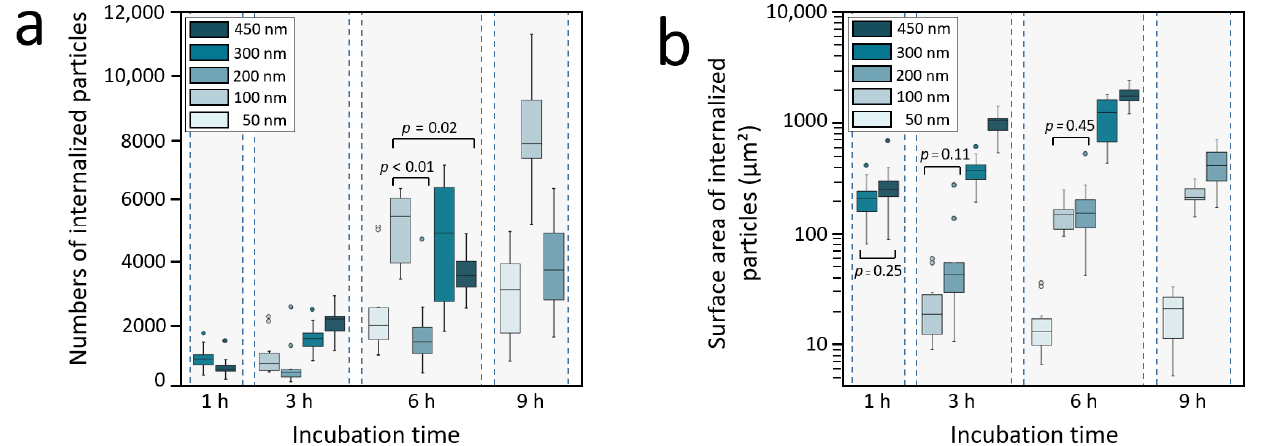
Figure 8. Internalization efficiencies. ( a ) Number of internalized NPs by one cell as a function of time ( p -values are only given for the data discussed in the text). ( b ) Surface area of internalized NPs as a function of time. In graph b, all the data are significantly different ( p < 0.05), except those for which a p -value is indicated (bilateral Mann-Whitney test).